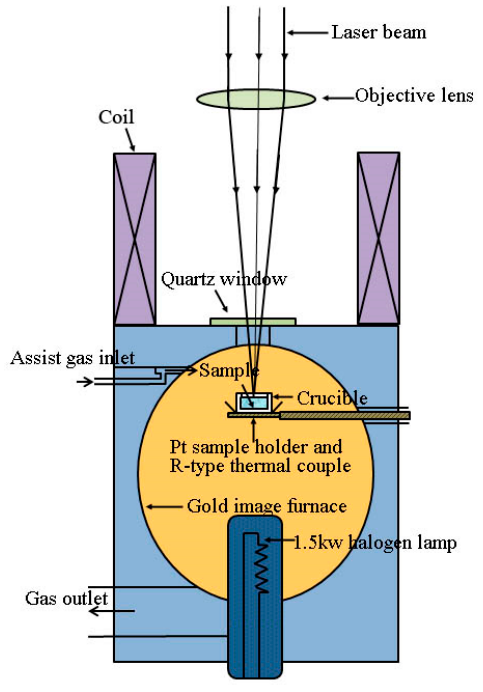
Figure 1. Sketch of the experimental apparatus.